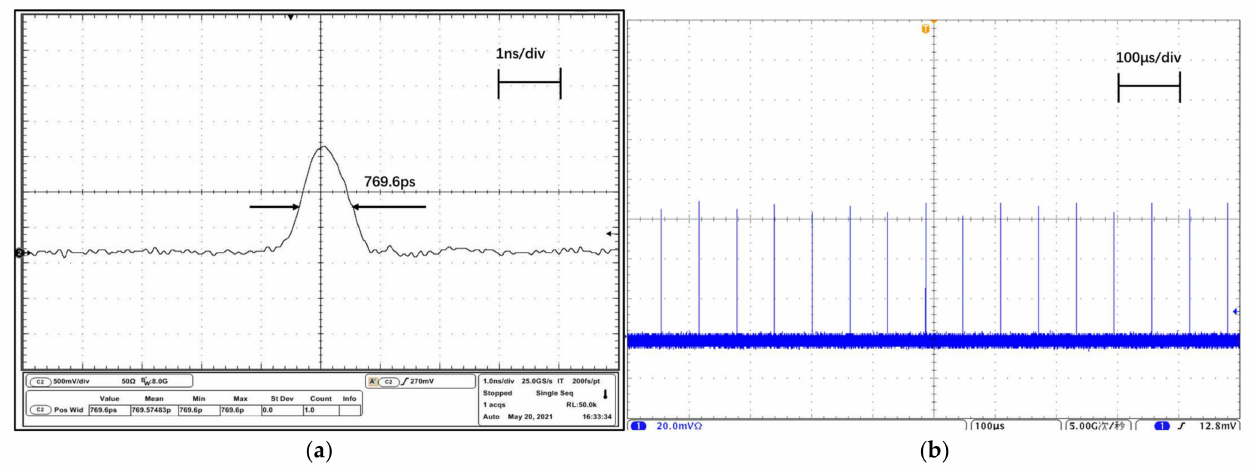
Figure 7. The pulse width and repetition rate of 532 nm. ( a ) Single-pulse profile and pulse width. ( b ) Pulse train profile and the pulse repetition